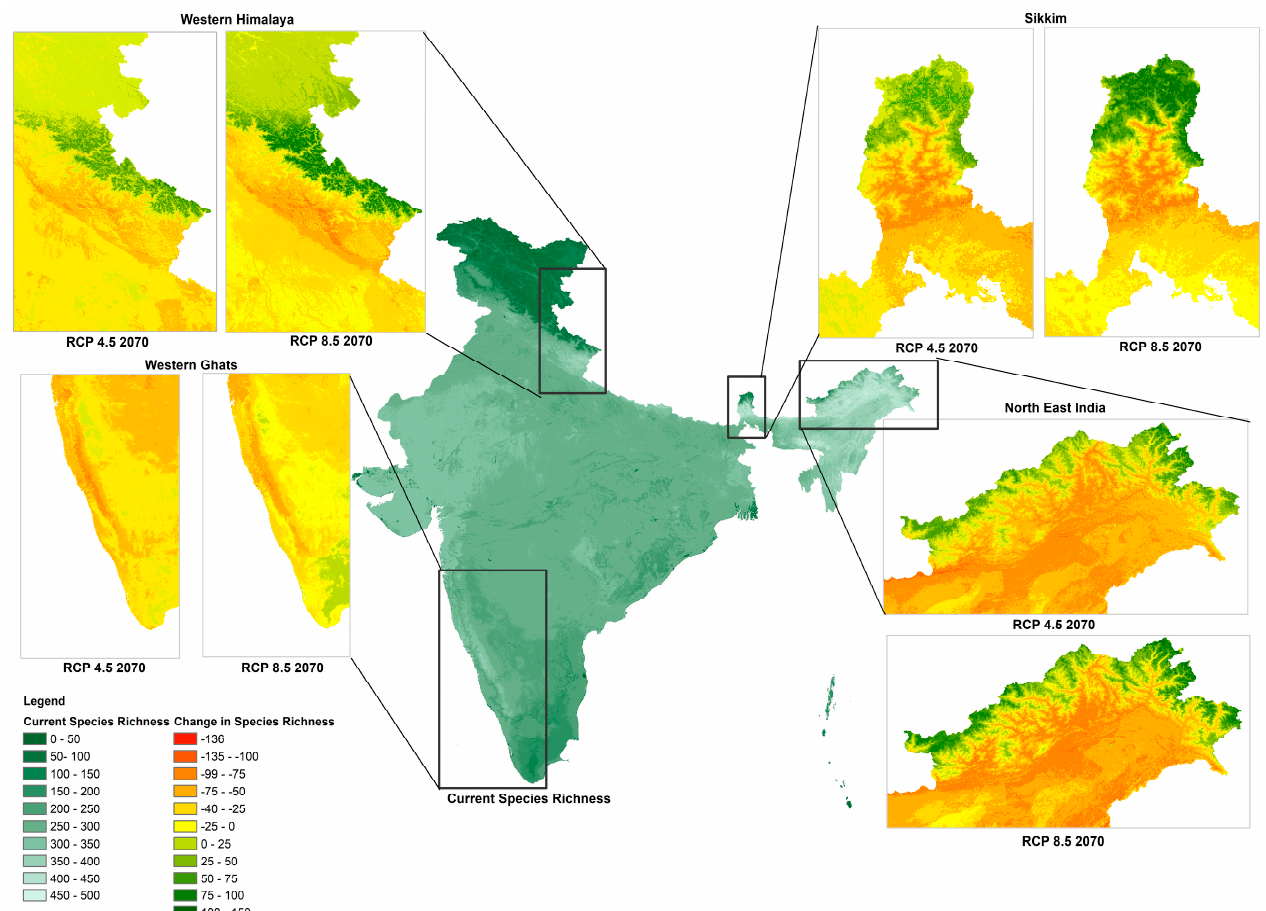
Figure 4. Species richness change for RCP 4.5 and RCP 8.5 scenarios in 2070.